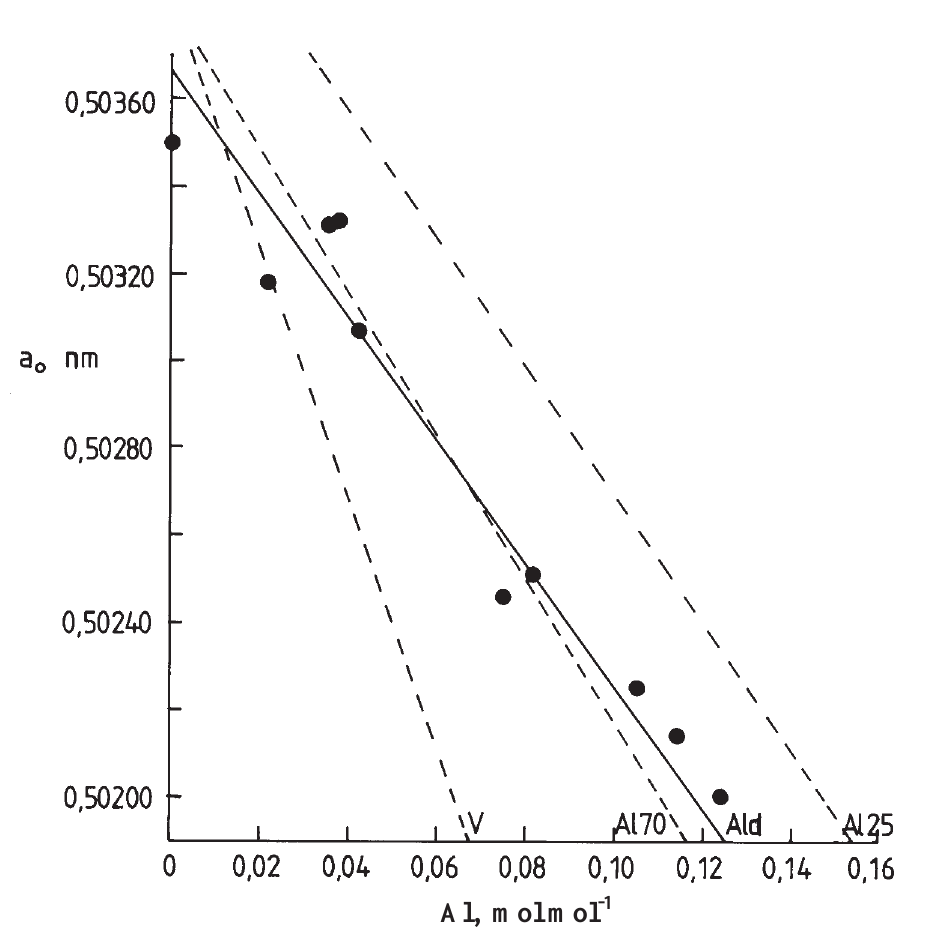
Figura 1. Relação entre o parâmetro a 0 e a substituição em Al segundo Vegard (V), a regressão de hematitas sintetizadas a 70 ° C (Al 70 ) e a 25 ° C (Al 25 ), e por extração com DCB (Ald) em hematitas